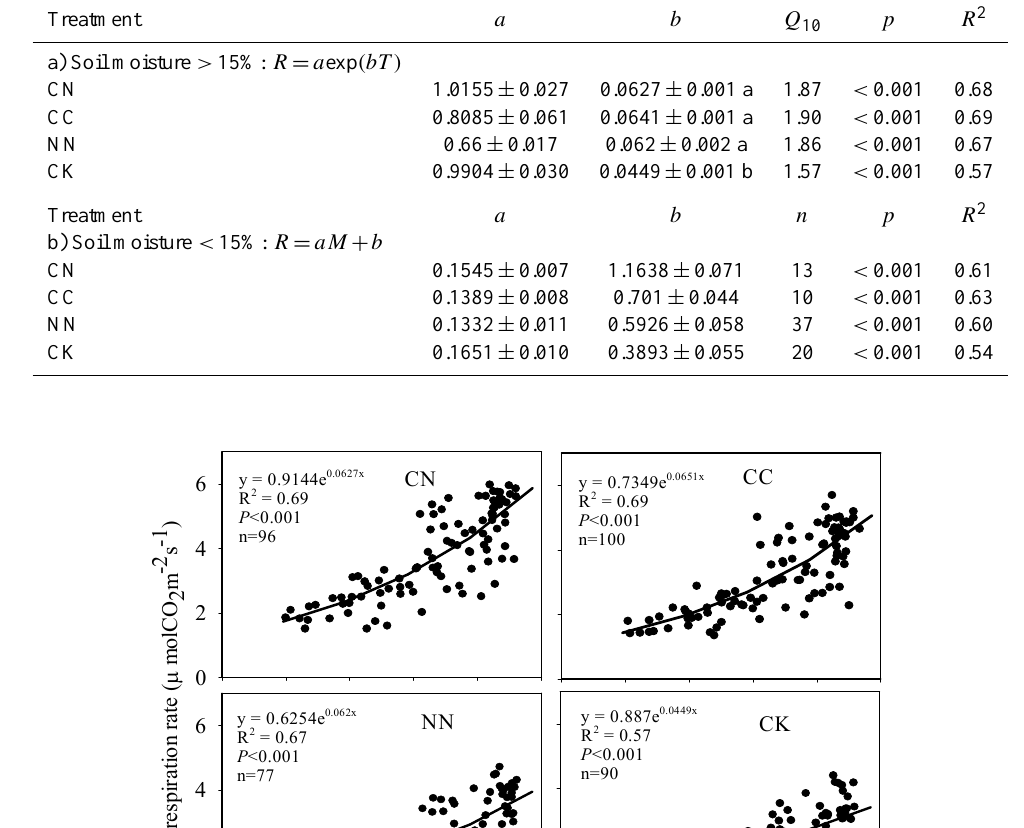
Table 4. Model for relationships between the soil respiration ( R ) and soil temperature at 5cm below the soil surface ( T ) and soil moisture of the top 5cm soil layer ( M ) (mean ± standard deviations). Standard deviation within each treatment showed the dispersion among open-top chambers employed for each treatment. n = 3 for the CN and CC treatments, n = 2 for the NN treatment and CK. Mean values of b in the exponential equation ( R = a exp(bT)) within a column with different lowercase letter have significant treatment differences at α =0.05 level. R 2 is the determination of coefficient. The treatments are: CK = control, NN = high N, CC = elevated CO 2 , CN = elevated CO 2 + high N. Unit: µmolCO 2 m − 2 s − 1 for R ; ◦ C for T and % for M .